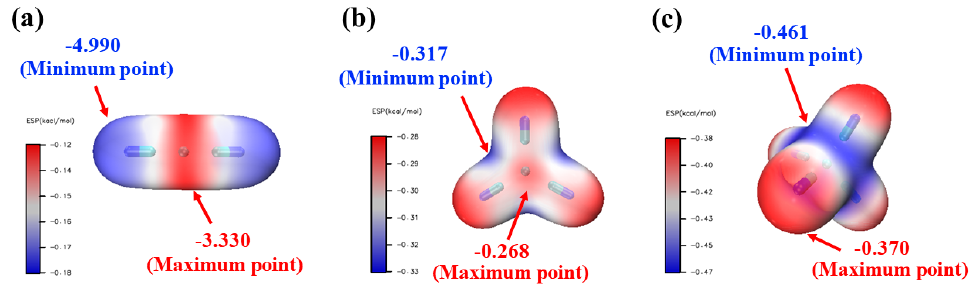
− , ( b ) Cu(CN) 32 − , and ( c ) Cu(CN) 43 −